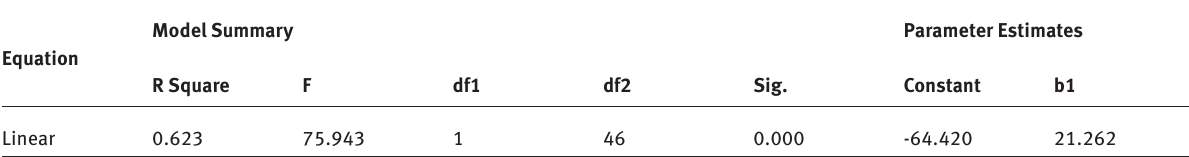
Table 2: Correlation and linear regression analysis of ADC value and SPARCC scoring